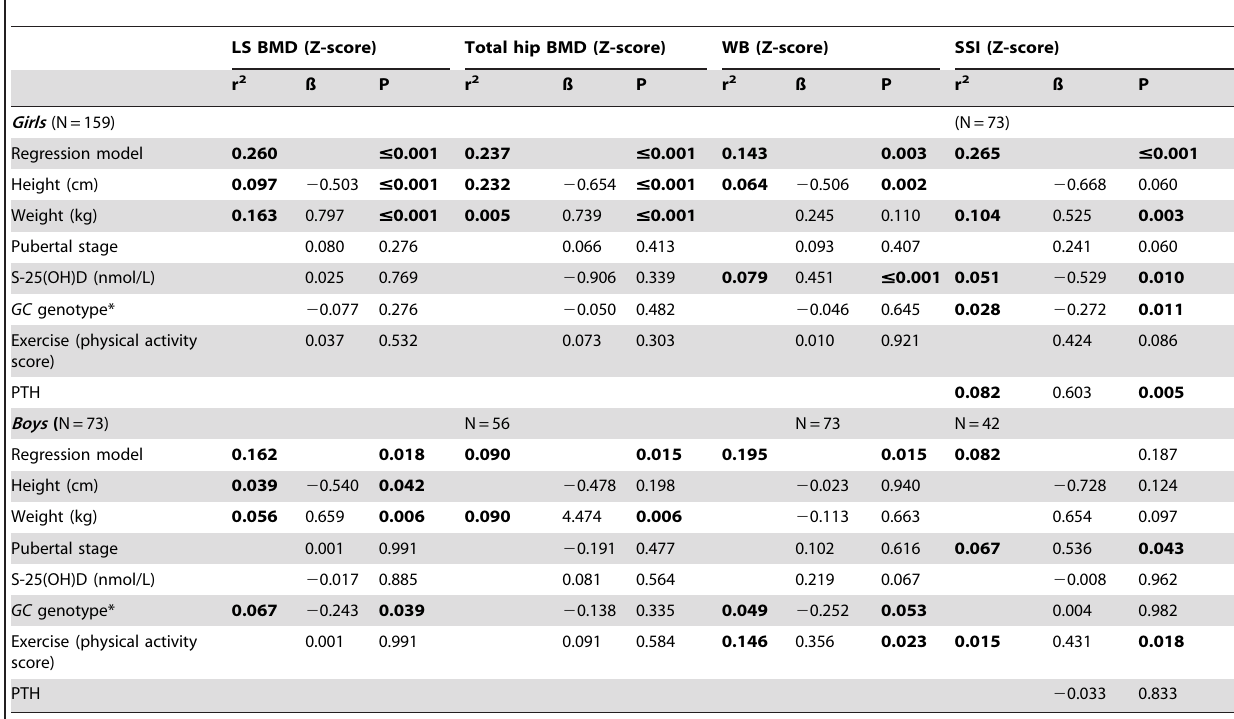
Table 6. Linear regression analysis for determinants of lumbar spine, total hip and whole body BMD and strength strain index Z- score in groups defined by